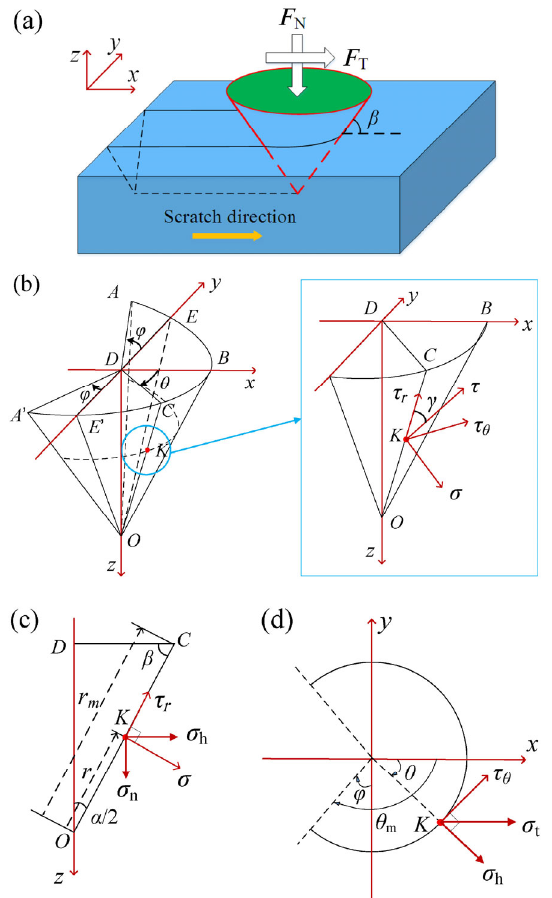
Fig. 1 (a) 3D view of the conical tip-substrate scratch; (b) schematic of the contact surface and stress components at point K ; (c) the stress components at point K from side view; (d) the stress components at point K from top view. Here,  is the conical apex angle; OD is the axis of conical tip; DB is the radius of the circle on the top contact surface;  is the included angle between planes OCD and OBD. r is the length of OK.  is the normal stress on contact surface (on plane OCD and perpendicular to OC ).  is the tangential stress on contact surface following the material flow direction at K .   is the angle between  and OC.  is along OC and is  is perpendicular to OCD. The   r h the stress component of  (on plane OCD and perpendicular to OD).  is the maximum included angle.  and  are the m t n resulting stresses at point K along the scratch direction and the axial direction,